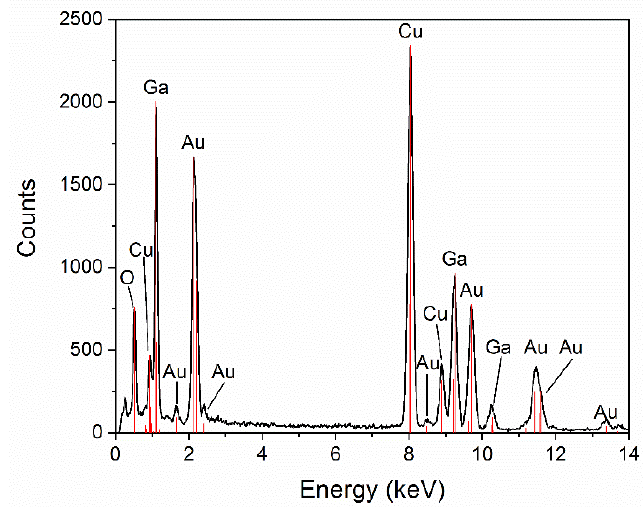
Figure 7. The chemical composition of Ga-Au alloy droplet anchored at the top of the nanowire. points that the synthesized β -Ga 2 O 3 nanowires are monocrystalline (Figure 8). The diffraction pattern of a beam of electrons passing through the examined sample